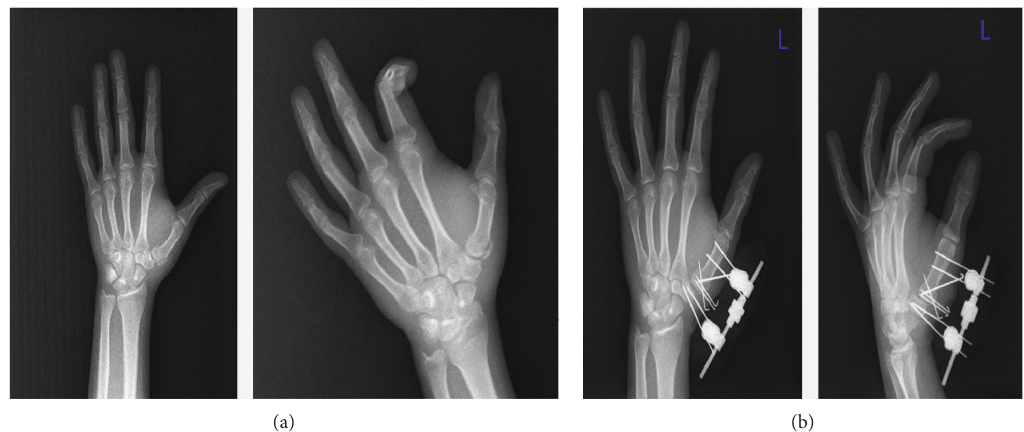
Figure 2: (a) Preop AP and oblique X-ray views of Rolando fracture. (b) Postop AP/lateral X-ray views of Rolando